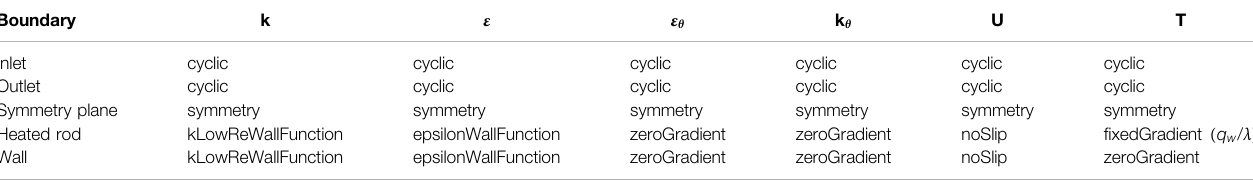
TABLE 5 | Boundary conditions imposed on each boundary.